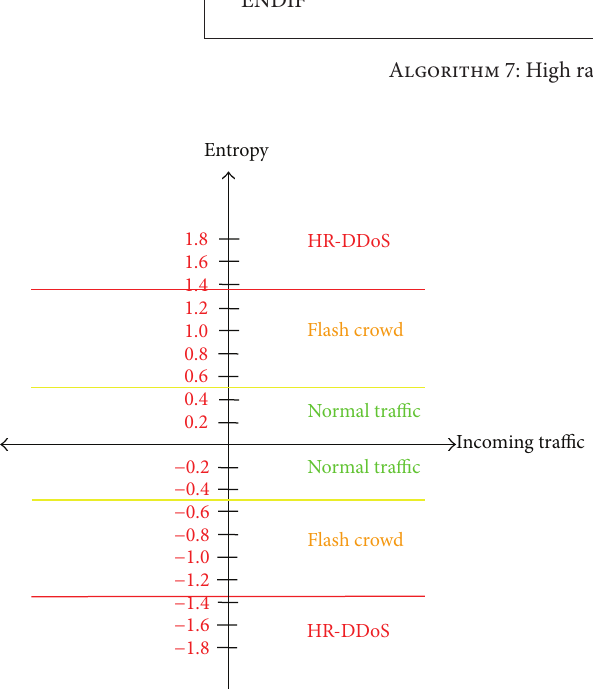
Figure 7: The overall entropy for the flash crowd (FC) attack case, high rate DDoS (HR-DDoS) attack case, and a normal traffic case.